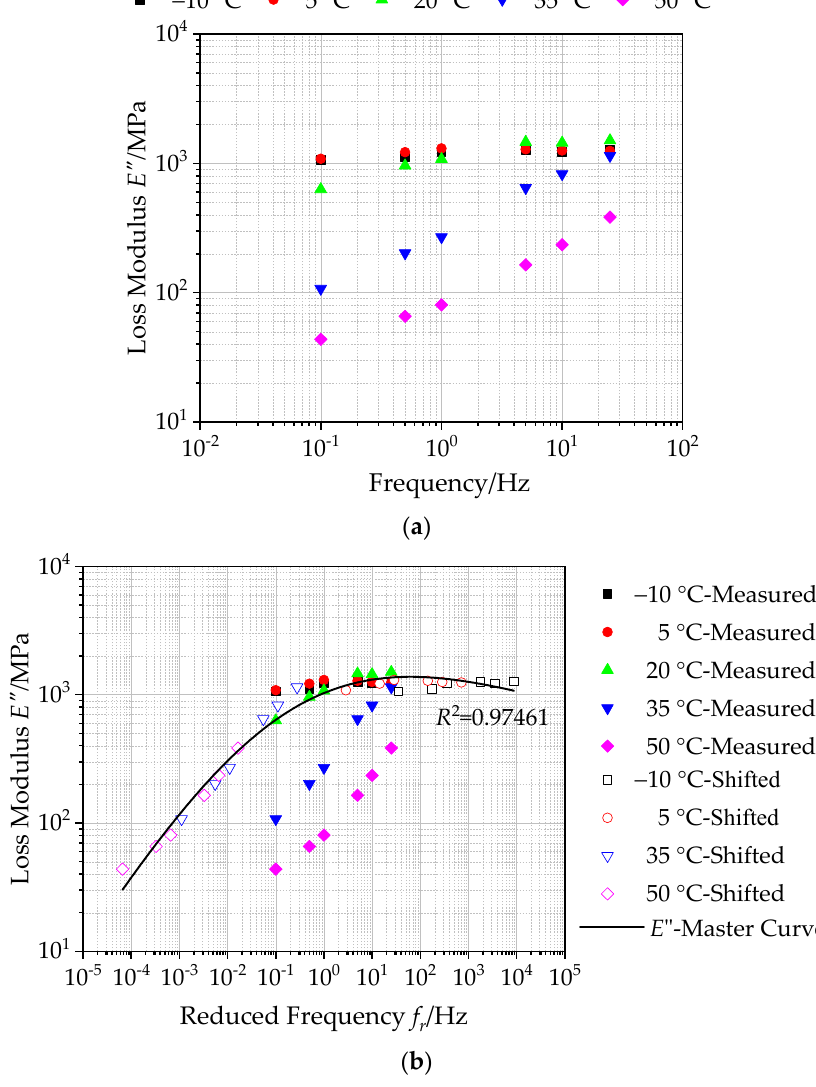
Figure 10. Loss modulus of asphalt mixtures with basalt fiber: ( a ) calculated loss modulus, ( b ) master curves of loss modulus (reference temperature = 20 °C).